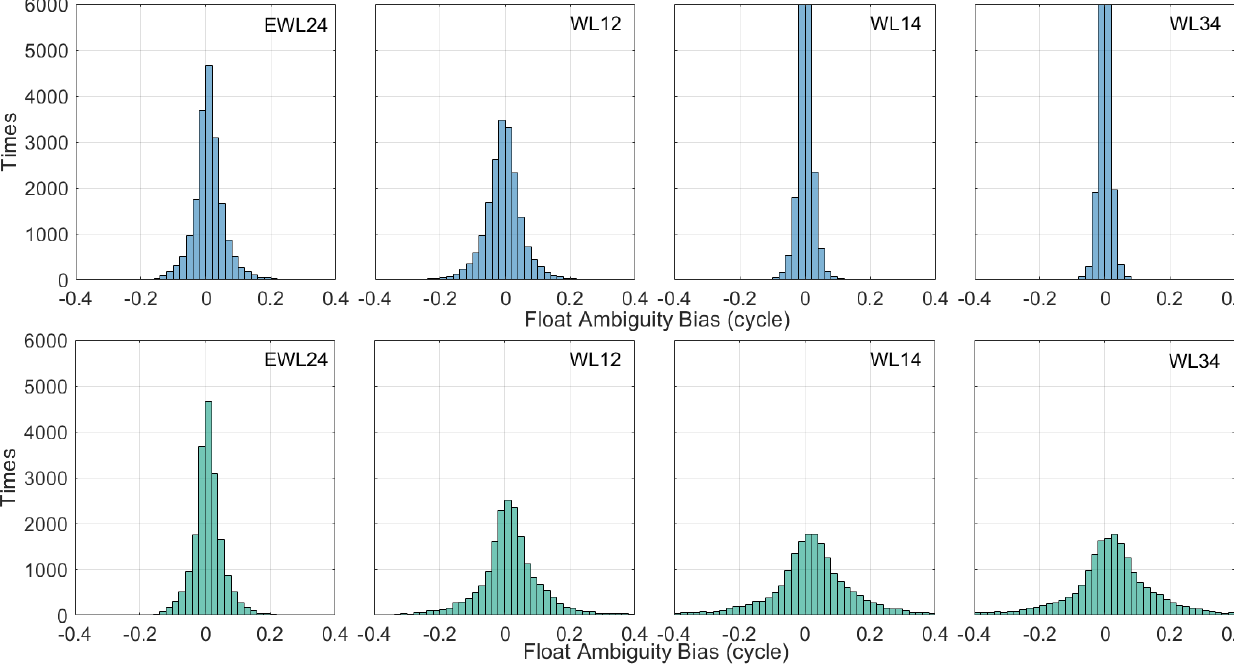
Figure 5. Histograms of EWL/WL float ambiguity bias.